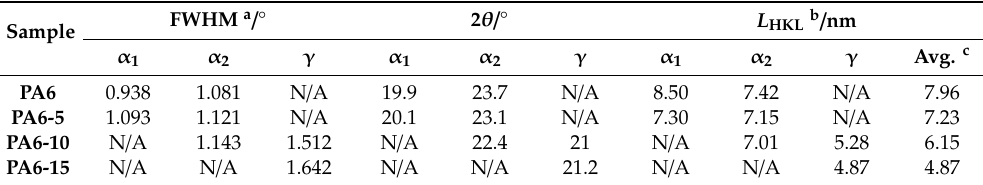
Figure 1. The wide-angle X-ray di ff raction (WAXD) profiles of the ( a ) pure polyamide 6 (PA6), ( b ) PA6-5, ( c ) PA6-10, and ( d ) PA6-15. Table 1. Crystalline parameters for copolyamides obtained from wide-angle X-ray di ff raction (WAXD). PA6: polyamide